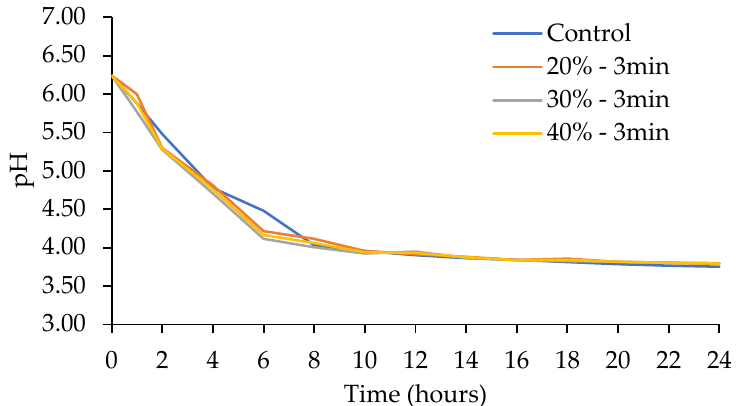
Figure 5. Effect of ultrasound amplitude on the growth curve of Lactobacillus acidophilus .